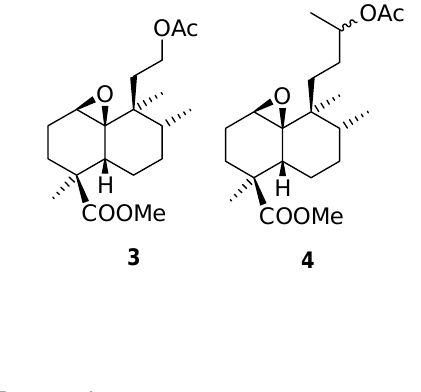
Figure 2. Starting materials obtained from ent -halimic